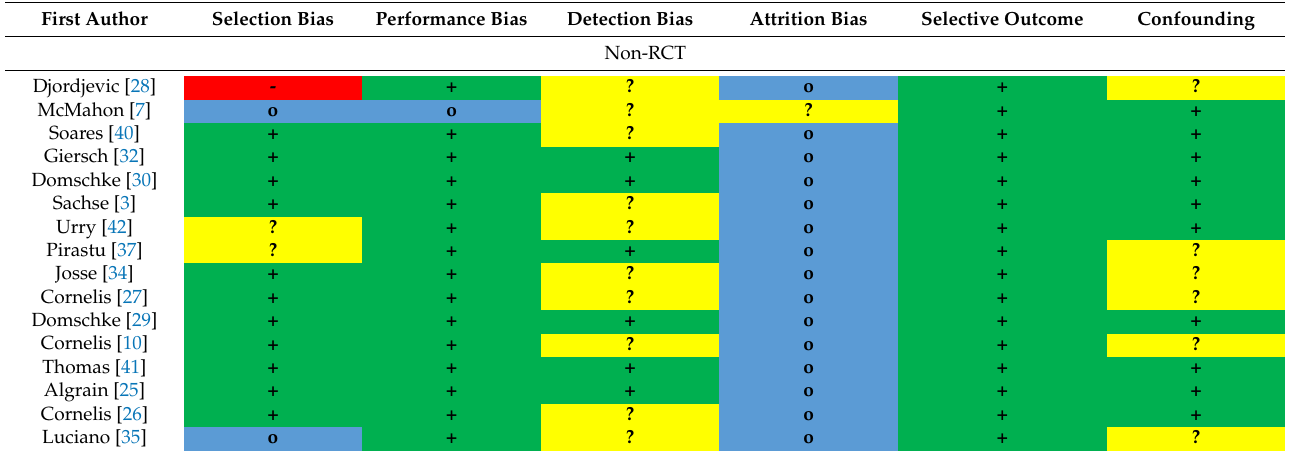
Table 3. Risk of bias assessment using the Research Triangle Institute (RTI) Item